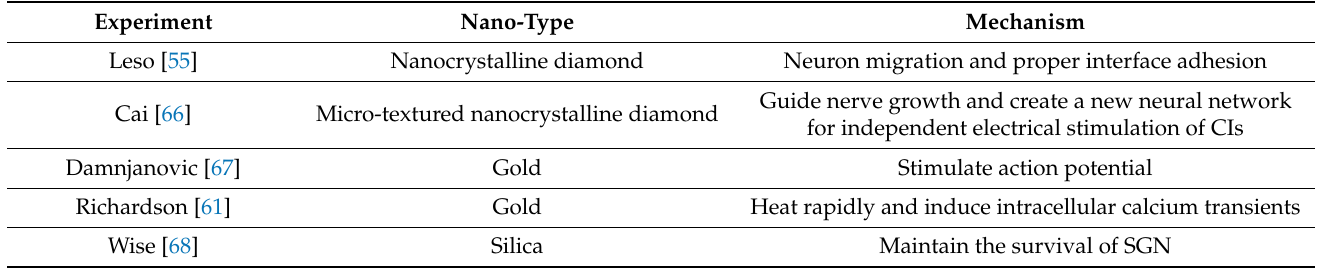
Table 8. Auxiliary electrical stimulation of CI by